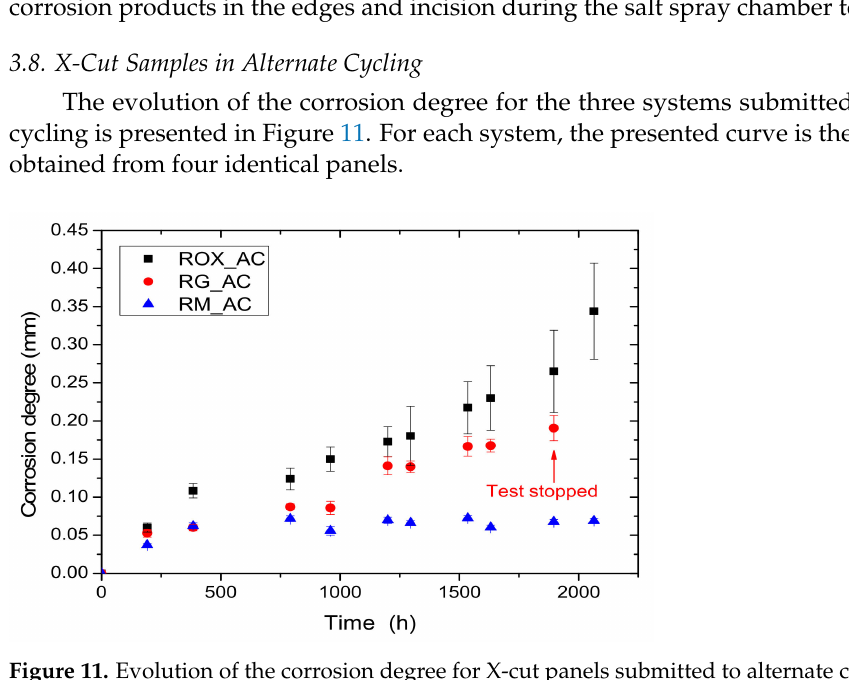
Figure 11. Evolution of the corrosion degree for X-cut panels submitted to alternate